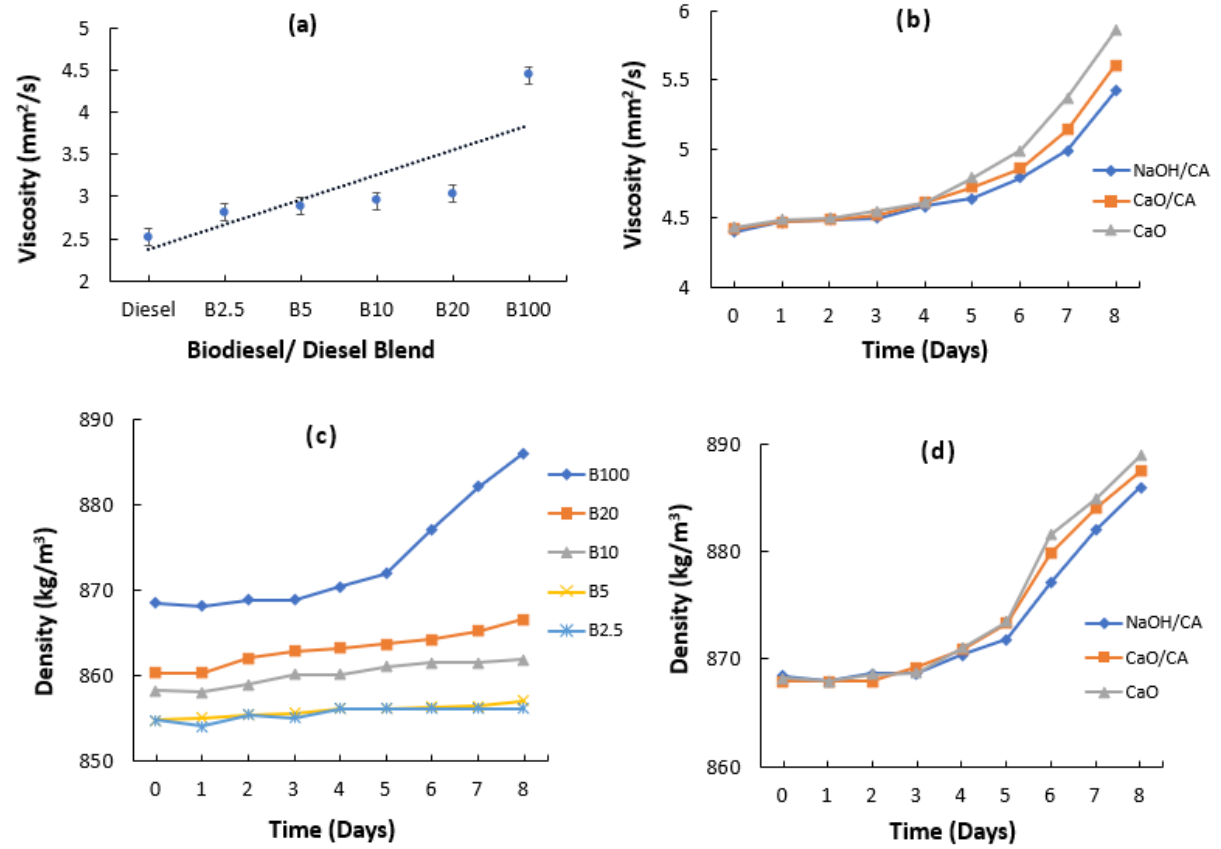
Figure 12. Fuel properties of biodiesel and blends. ( a ) Viscosity of biodiesel/diesel blends and diesel, ( b ) viscosity of biodiesel under accelerated storage, ( c ) density of biodiesel/diesel blends and diesel and ( d ) density of biodiesel.